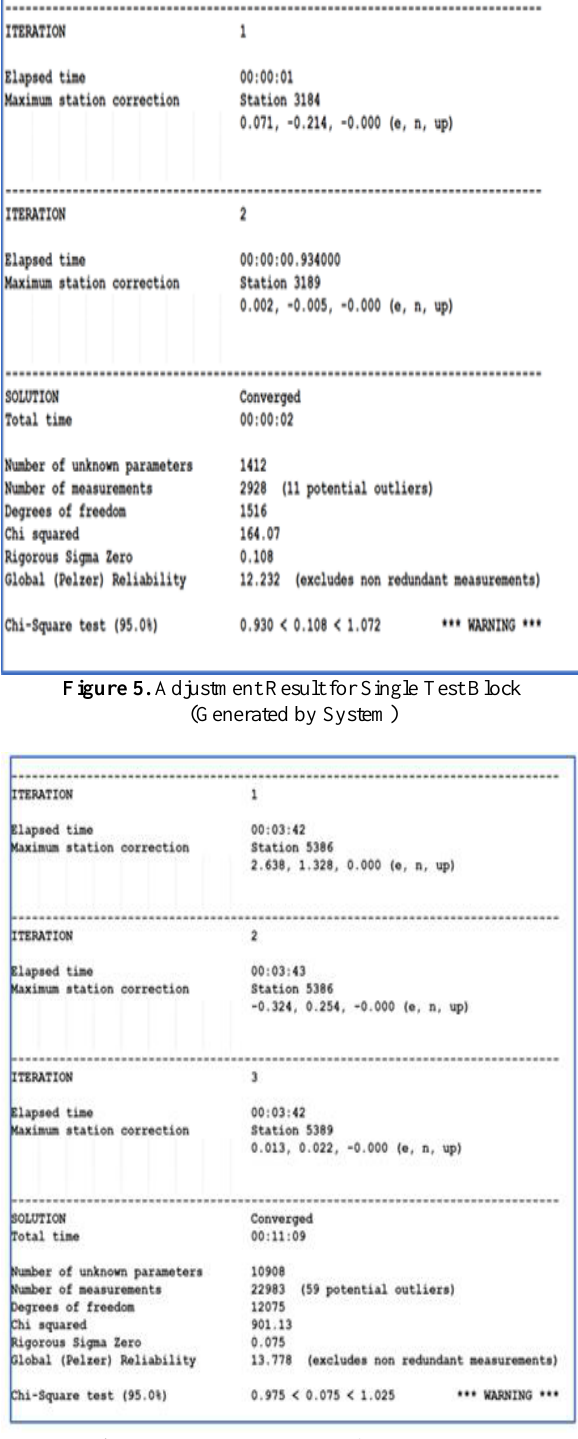
Figure 6. Adjustment Result for Entire Block (Generated by